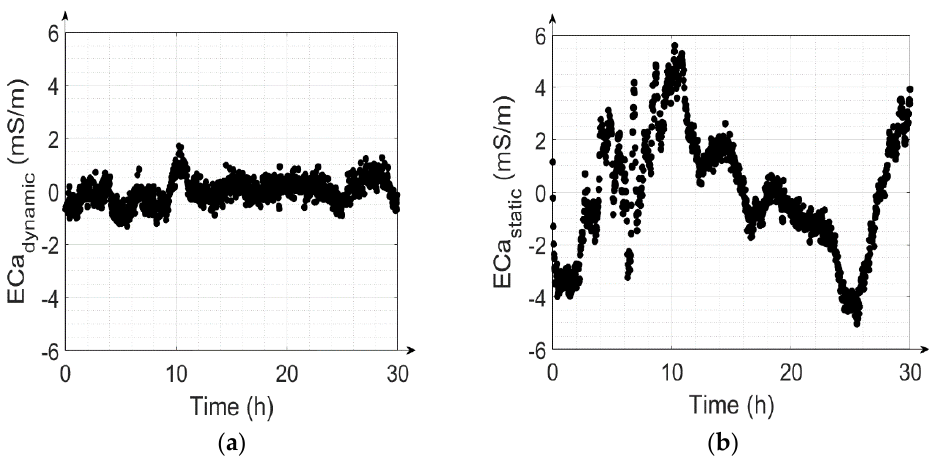
Figure 9. Individually corrected ECa values calculated using ( a ) the LPF (dynamic drift correction); ( b ) no LPF (static drift correction). The ECa values were shifted to have a zero mean to focus on the changes in ECa instead of the absolute values.